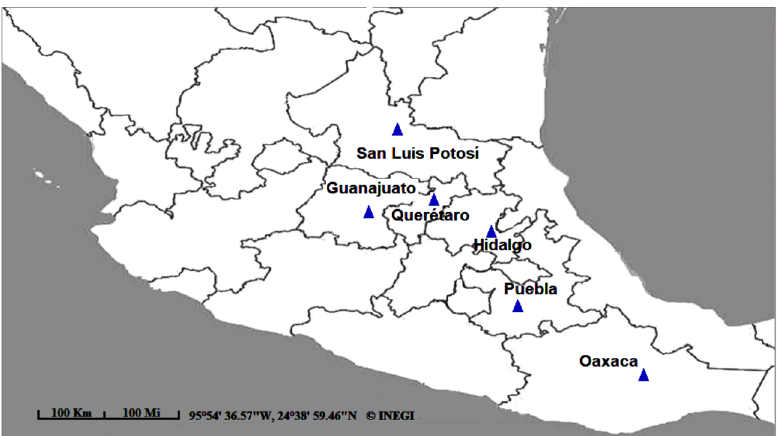
Figure 11. Geographical location of Brickellia veronicifolia populations grown in